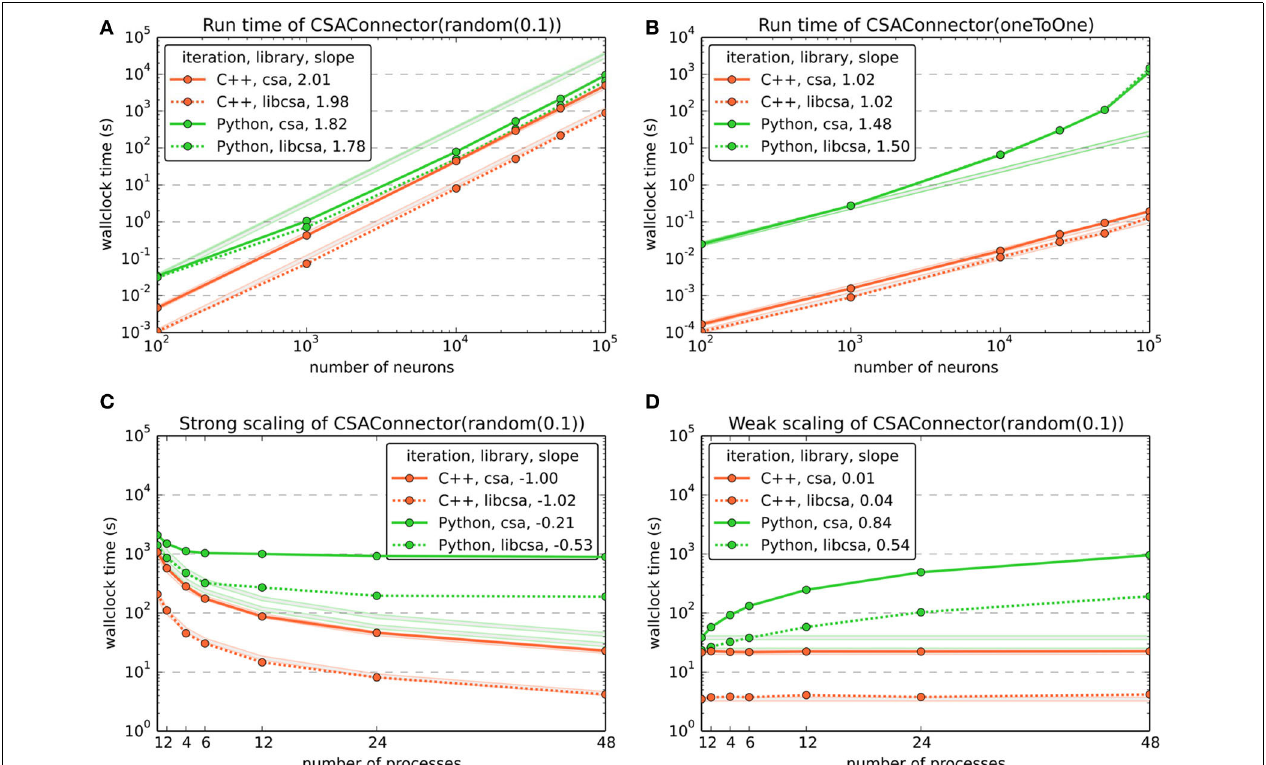
FIGURE 4 | Benchmark results for the use of CSA in NEST through PyNN, comparing the two CSAConnector implementations explained in section 5 and two of the CSA implementations mentioned in section 3. Color and dash codes are given in the legends. Slope is the ratio of logarithms of the last and first data point shown. Pale lines denote the expected scaling. (A) Shows the run time for connecting a network using CSAs random mask with a probability of 0.1 for different numbers of neurons. This connector creates O ( n 2 ) connections for n neurons. The expected slope is thus 2. (B) Shows the same as in (A) , but using CSAs